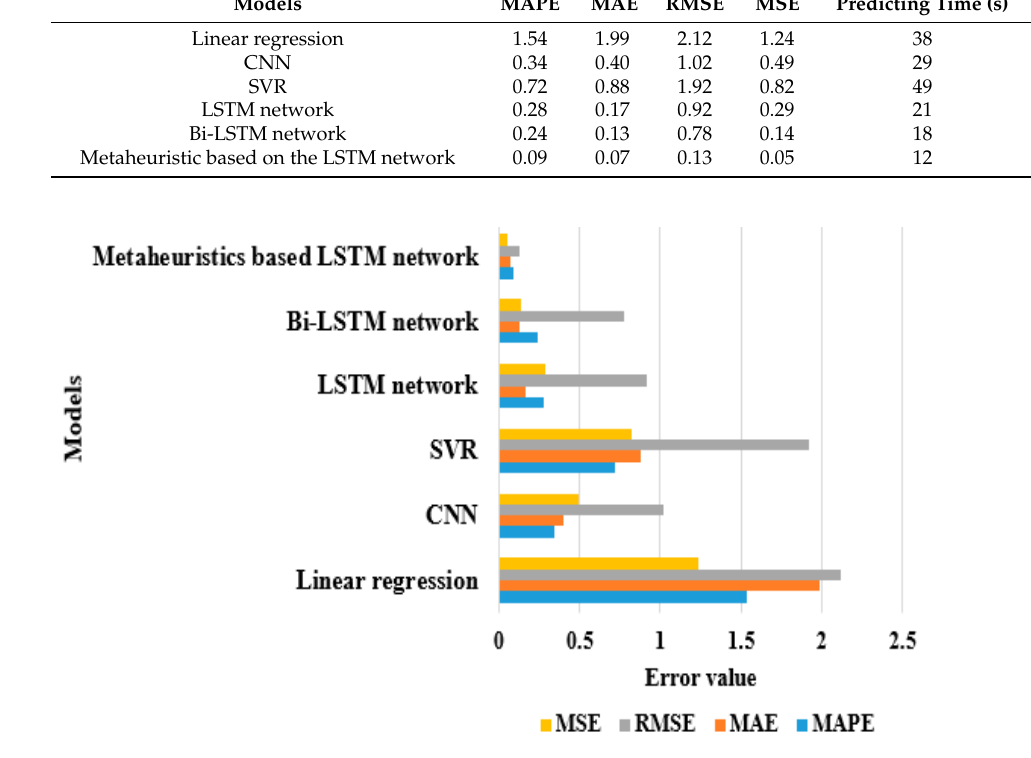
Figure 7. Graphical presentation of the experimental models for the AEP dataset.